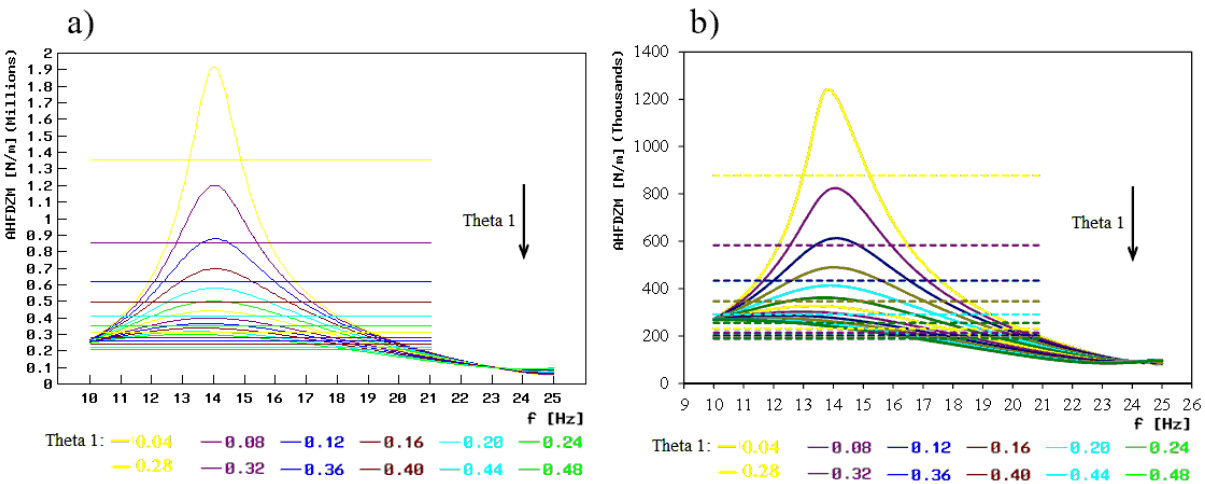
Figure 5: Factors of gain (AHFDZM) in the force measured by the real diagnostic tester, i.e. under the exciter (relative to the input force), close to the second natural frequency of the front “quarter car” for various damping values ϑ 1 (Theta1): the horizontal lines represent the √ values of AHFDZ max / 2 ; a) results for the linear model; b) results for the nonlinear model